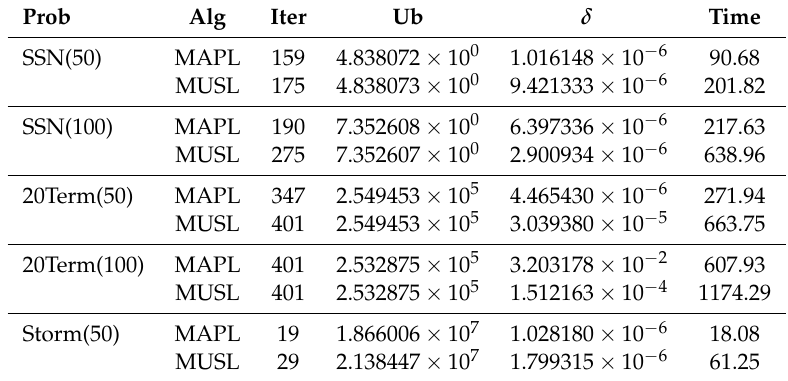
Table 4. MAPL and MUSL methods on SP